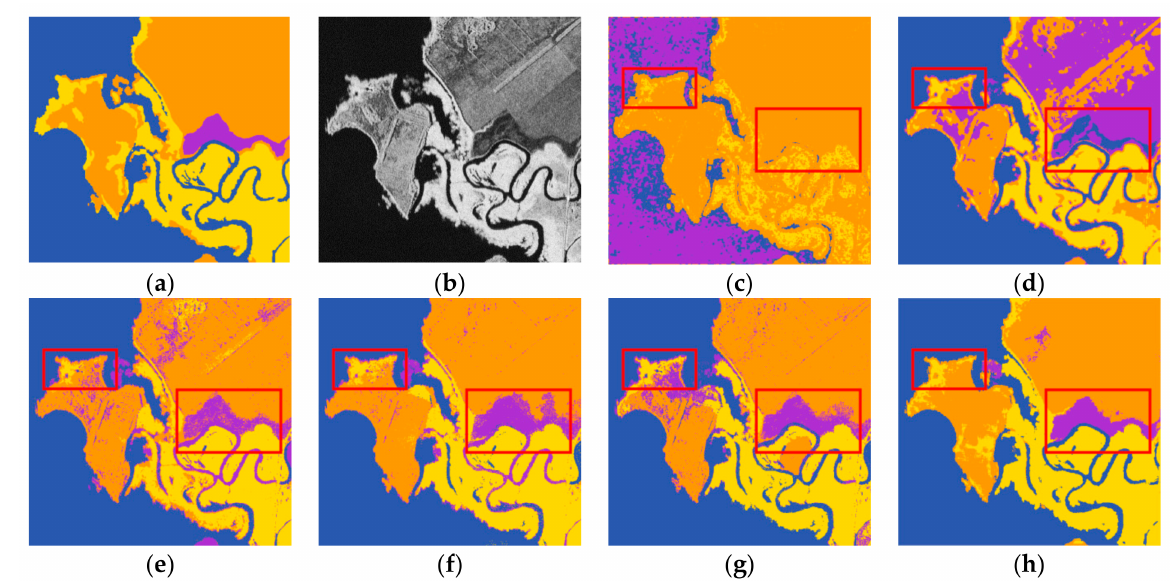
Figure 7. Results of a real SAR image: ( a ) ground truth; ( b ) real SAR image; ( c ) SVM; ( d ) CKS-FCM; ( e ) CKFF; ( f ) SVM-CK; ( g ) MWSG; ( h )